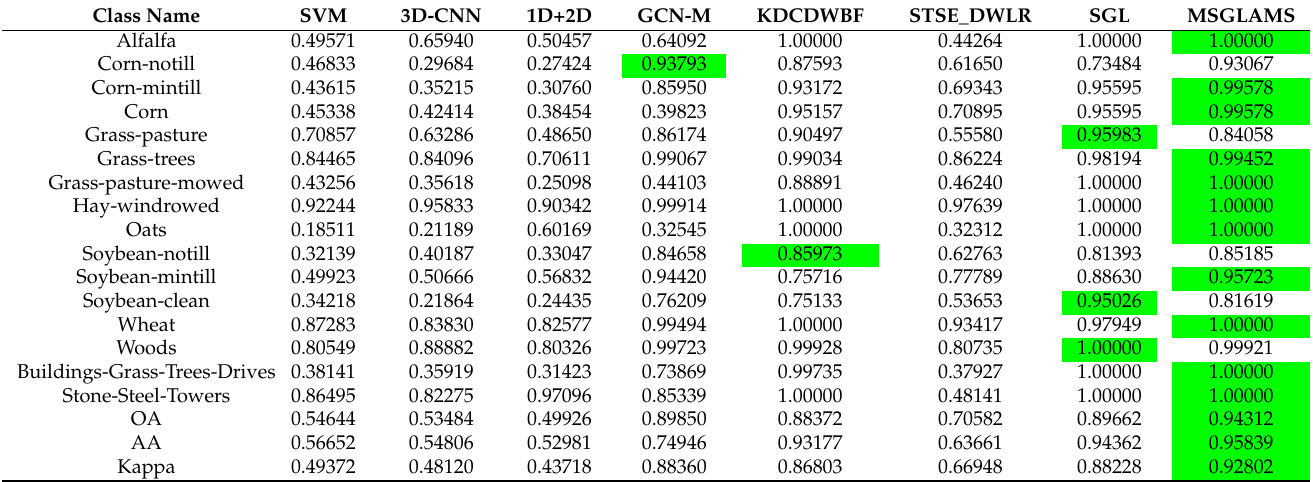
Table 5. Classification accuracy for the Indian Pines image with ten labeled samples per class.